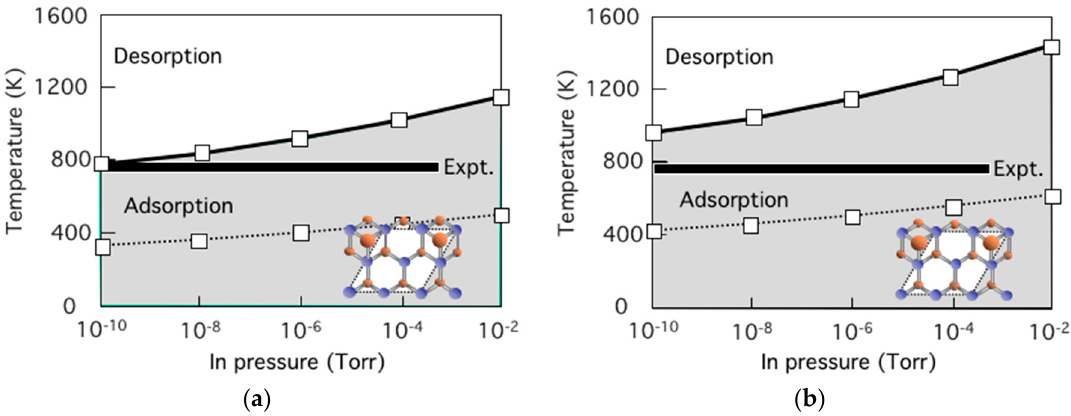
Figure 3. Calculated adsorption-desorption boundaries for In atom without (dotted line) and with simultaneous As adsorption (solid line) on the (2 × 2) with In-vacancy of ( a ) the InAs(111)-WL and ( b ) the InAs(111)-FR as functions of temperature and BEP of In. Black area denotes the temperature range of the conventional MBE growth.